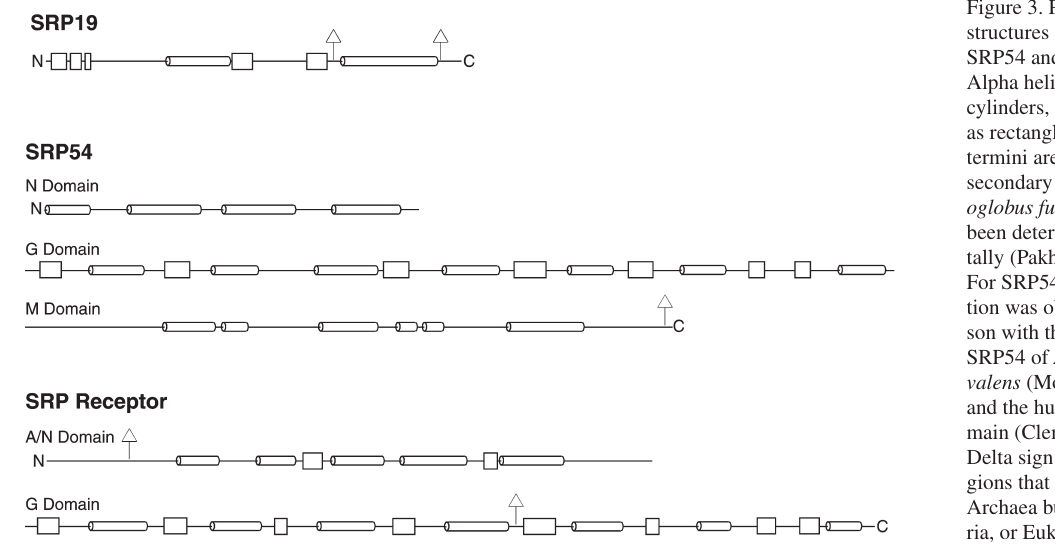
Figure 3. Protein secondary structures of archaeal SRP19, SRP54 and the SRP receptor. Alpha helices are drawn as cylinders, beta conformations as rectangles. The N- and C- termini are indicated. Only the secondary structure of Archae- oglobus fulgidus SRP19 has been determined experimen- tally (Pakhomova et al.